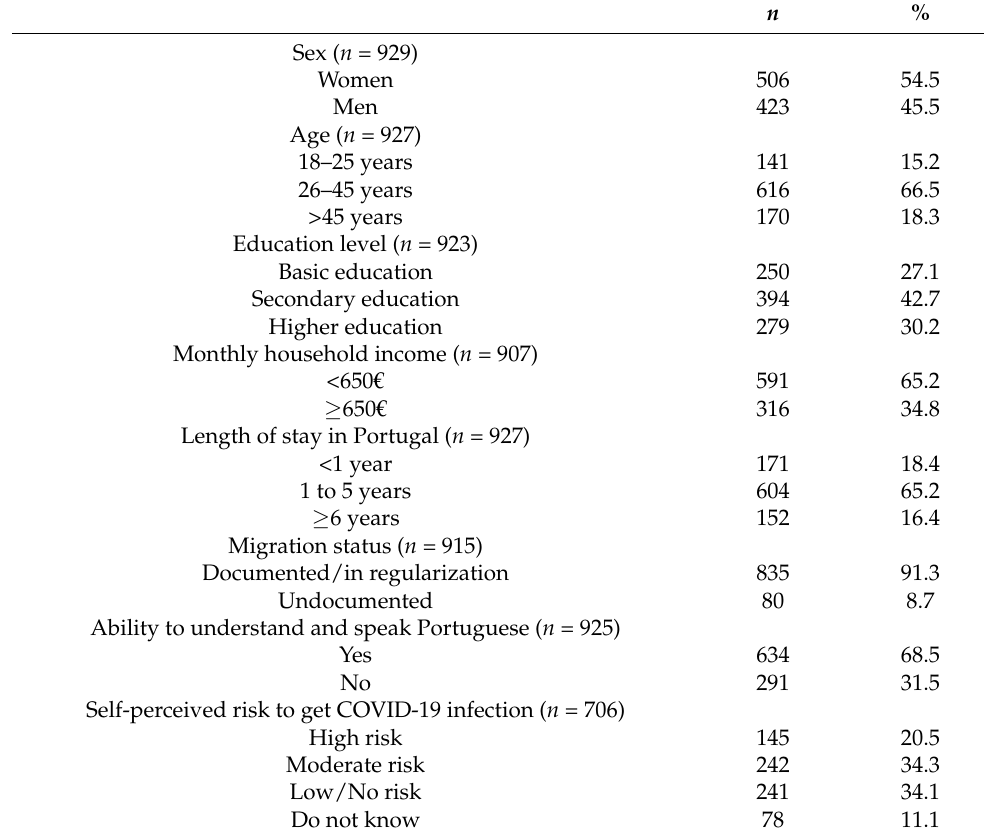
Table 1. Characteristics of the participants ( n =